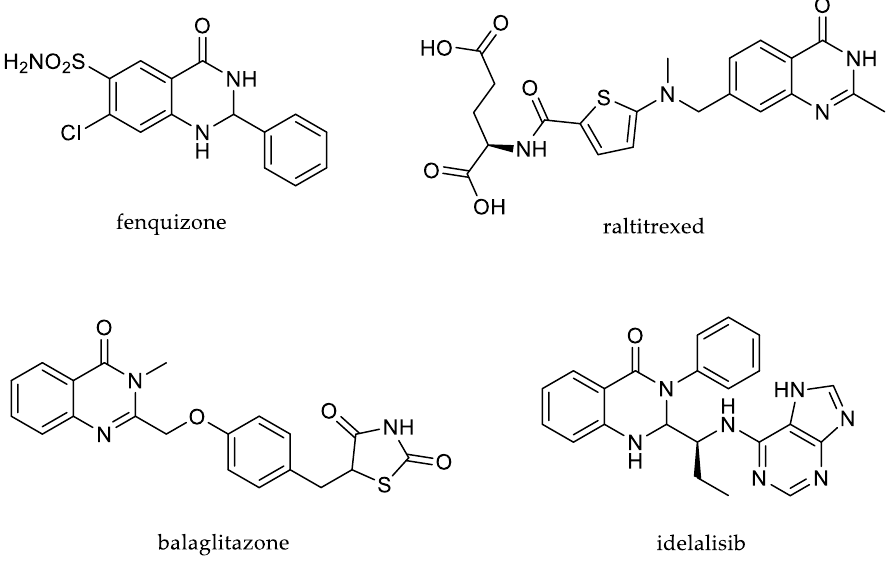
Figure 2. Quinazolinone-based registered drugs